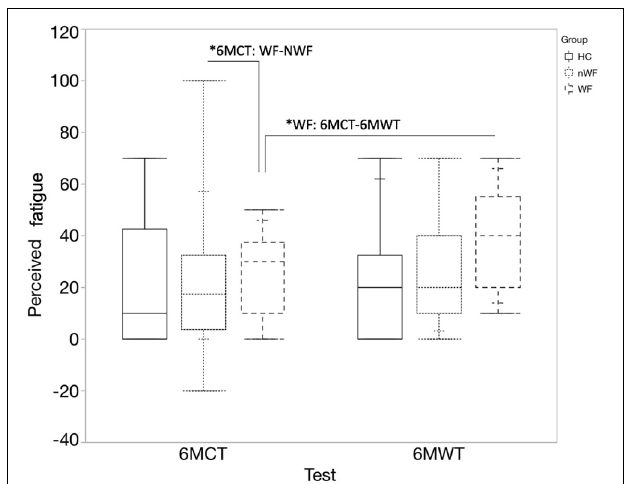
FIGURE 4 | Median change in perceived fatigue (quartiles) during 6MWT and 6MCT. Full blocks represent data of healthy controls (HC); block with stripes pattern represents persons with MS with walking fatigability (WF), block with dot pattern represents persons with MS without walking fatigability (NWF). *6MCT: WF-NWF: significant difference in change in perceived fatigue between the WF and NWF group for the 6MCT ( p = 0.042). *WF: 6MCT-6MWT: significant difference in change in perceived fatigue between 6MCT and 6MWT in persons with WF ( p =